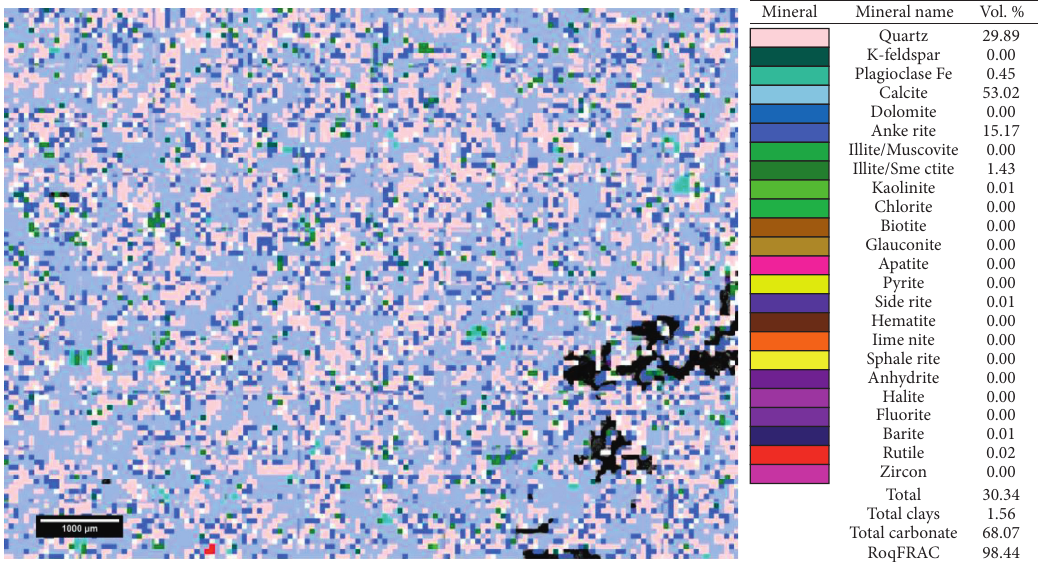
Figure 2: Component analysis of a partial kurkar